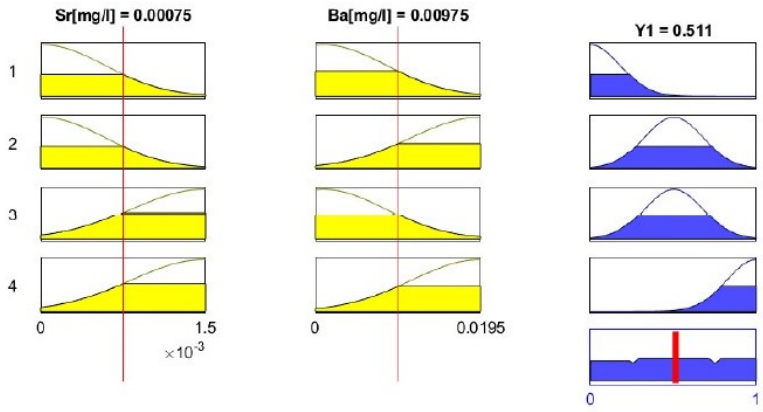
Figure 16. The inference procedure conducted within the MATLAB environment.